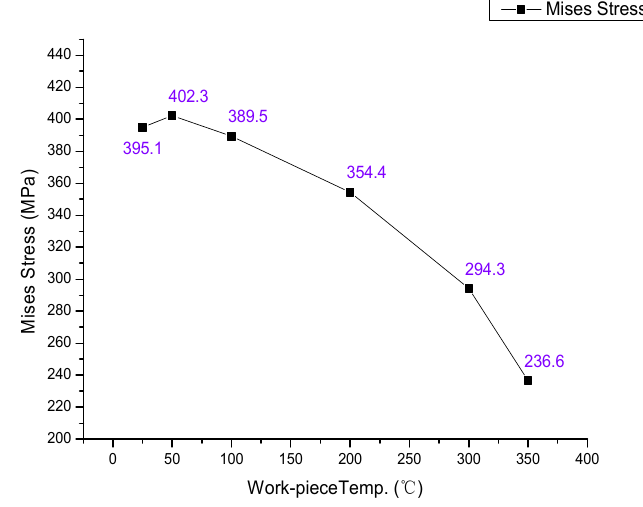
Figure 12. Von Mises stress at different workpiece temperatures.